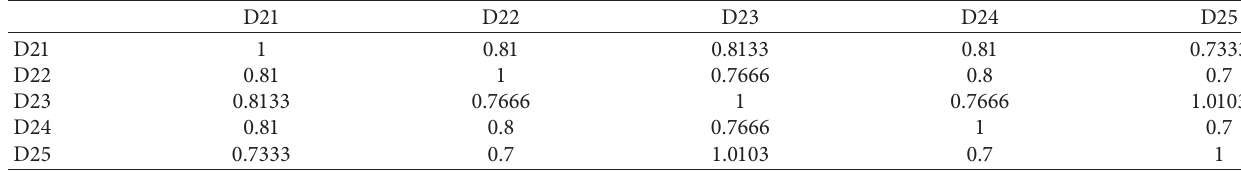
Table 8: Interval multiplicative matrix.